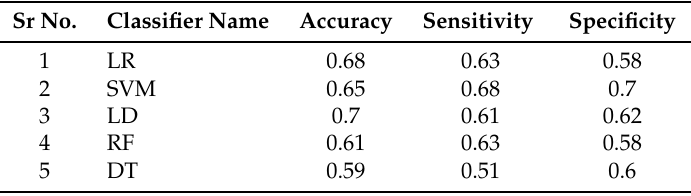
Table 4. 10-Fold Results based on the Top 60 Selected Features based on Proposed 3-Stage Approach. Sr No.